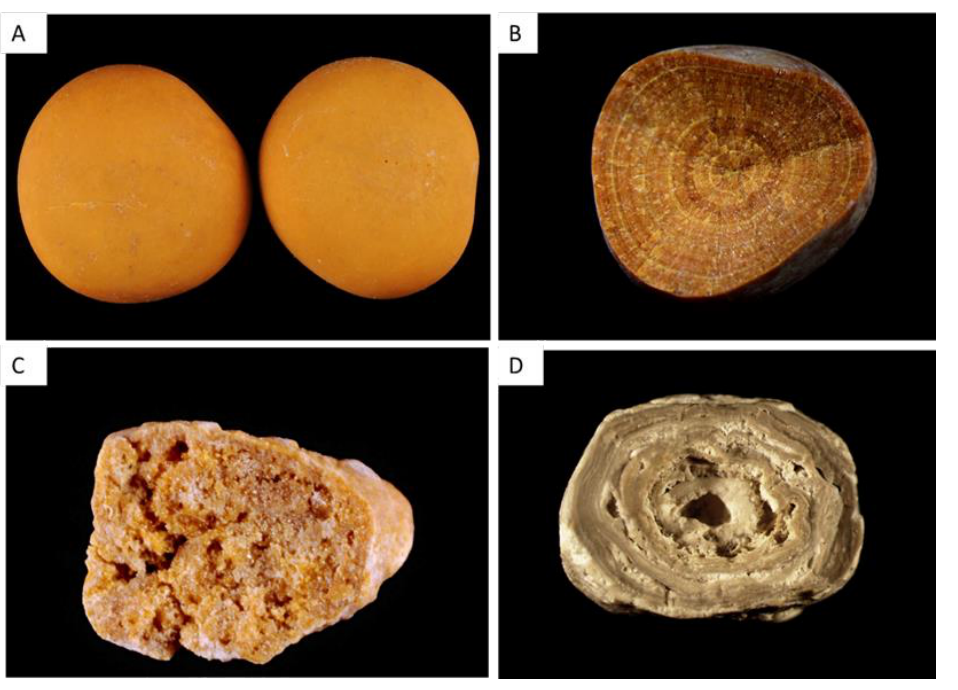
Figure 3. Type III stones, made of uric acid or urates. ( A ) Type IIIa stone with a typical smooth surface and orange color. ( B ) Type IIIa stone section, with concentric layers. ( C ) Type IIIb stone section, with a porous structure. ( D ) Type IIId stone section showing alternatively thick, brown and thin, clear layers with small porous zones.